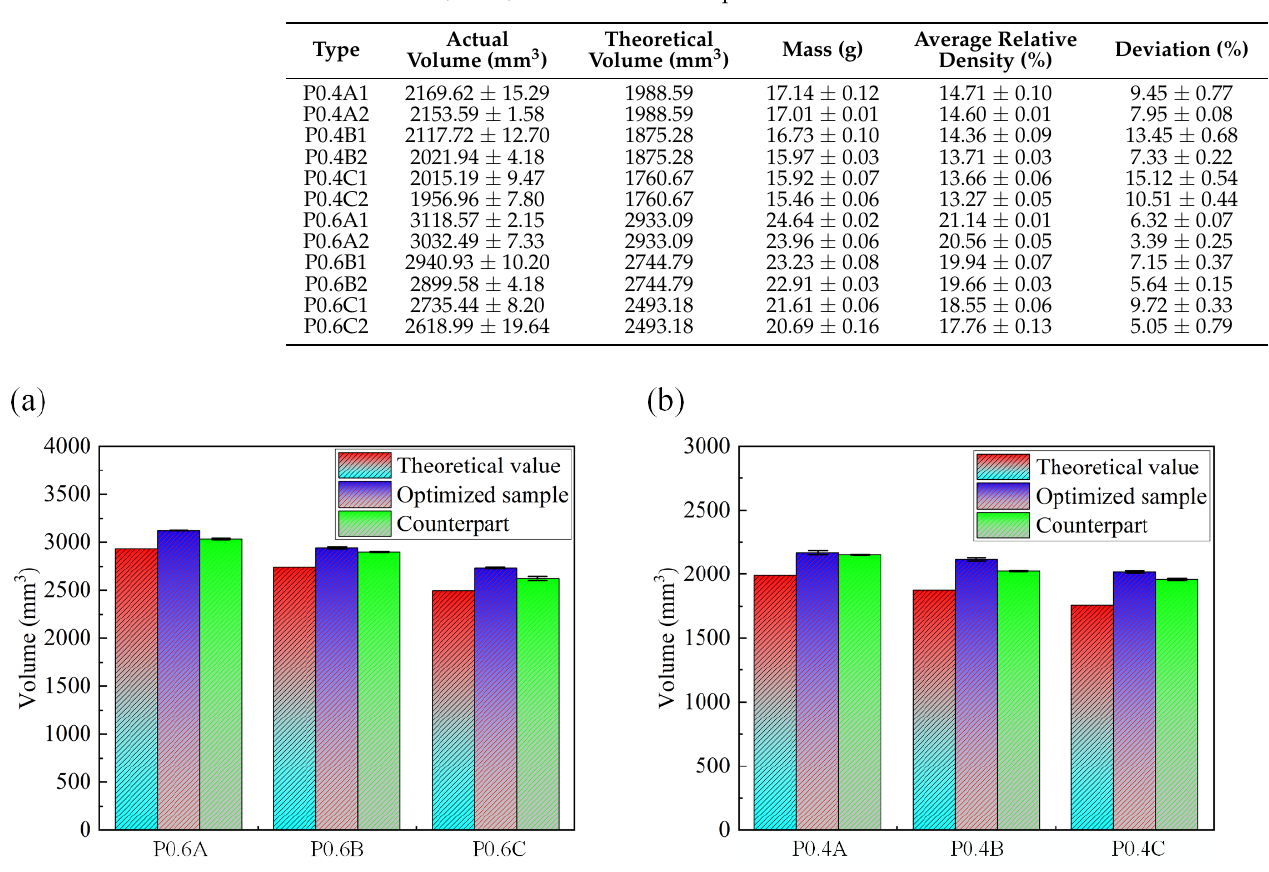
Table 3. Volume, mass, and densities of samples.